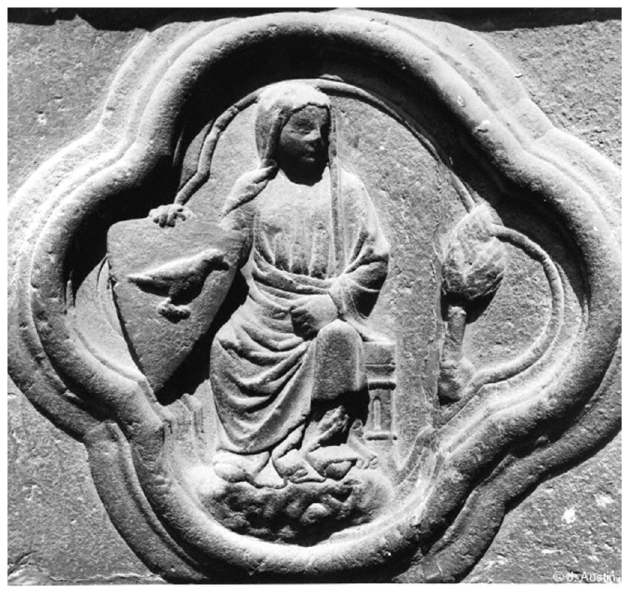
Figure 2. Humility, 1220–1235, Amiens Cathedral.